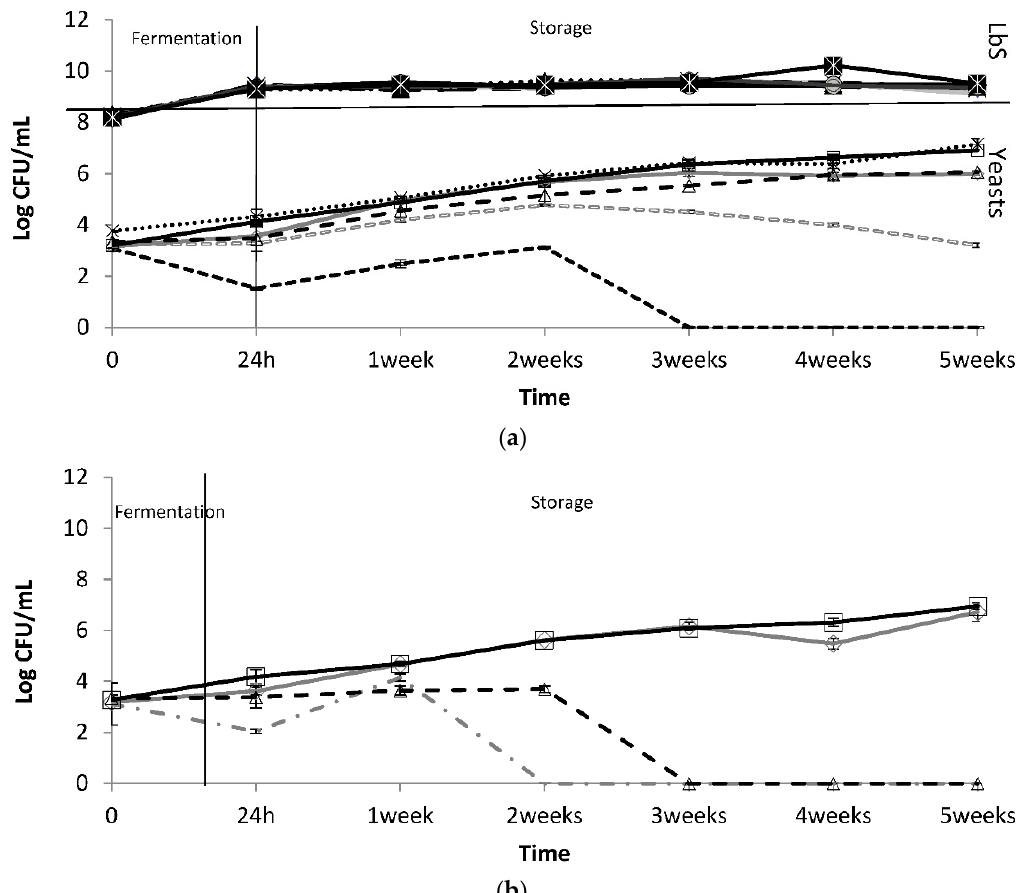
( b ) Figure 1. Growth kinetics of LbS and yeasts during the preliminary cow kefir fermentation and Figure 1. Growth kinetics of LbS and yeasts during the preliminary cow kefir fermentation and Figure 1. Growth kinetics of LbS and yeasts during the preliminary cow kefir fermentation and Figure 1. Growth kinetics of LbS and yeasts during the preliminary cow kefir fermentation and Figure 1. Growth kinetics of LbS and yeasts during the preliminary cow kefir fermentation and Figure 1. Growth kinetics of LbS and yeasts during the preliminary cow kefir fermentation and Figure 1. Growth kinetics of LbS and yeasts during the preliminary cow kefir fermentation and Figure 1. Growth kinetics of LbS and yeasts during the preliminary cow kefir fermentation and storage. At the top of the graph ( a ), the trend of the only LbS in each trial, represented as Lb fol- Figure 1. Growth kinetics of LbS and yeasts during the preliminary cow kefir fermentation and storage. At the top of the graph ( a ), the trend of the only LbS in each trial, represented as Lb fol- storage. At the top of the graph ( a ), the trend of the only LbS in each trial, represented as Lb fol- storage. At the top of the graph ( a ), the trend of the only LbS in each trial, represented as Lb fol- Figure 1. Growth kinetics of LbS and yeasts during the preliminary cow kefir fermentation and Figure 1. Growth kinetics of LbS and yeasts during the preliminary cow kefir fermentation and Figure 1. Growth kinetics of LbS and yeasts during the preliminary cow kefir fermentation and Figure 1. Growth kinetics of LbS and yeasts during the preliminary cow kefir fermentation and Figure 1. Growth kinetics of LbS and yeasts during the preliminary cow kefir fermentation and storage. At the top of the graph ( a ), the trend of the only LbS in each trial, represented as Lb fol- storage. At the top of the graph ( a ), the trend of the only LbS in each trial, represented as Lb fol- Figure 1. Growth kinetics of LbS and yeasts during the preliminary cow kefir fermentation and Figure 1. Growth kinetics of LbS and yeasts during the preliminary cow kefir fermentation and Figure 1. Growth kinetics of LbS and yeasts during the preliminary cow kefir fermentation and Figure 1. Growth kinetics of LbS and yeasts during the preliminary cow kefir fermentation and Figure 1. Growth kinetics of LbS and yeasts during the preliminary cow kefir fermentation and storage. At the top of the graph ( a ), the trend of the only LbS in each trial, represented as Lb fol- storage. At the top of the graph ( a ), the trend of the only LbS in each trial, represented as Lb fol- storage. At the top of the graph ( a ), the trend of the only LbS in each trial, represented as Lb followed lowed by the name of the associated yeast: LbS control trial ( ), LbS with D. hansenii 36 ( storage. At the top of the graph ( a ), the trend of the only LbS in each trial, represented as Lb fol- storage. At the top of the graph ( a ), the trend of the only LbS in each trial, represented as Lb fol- storage. At the top of the graph ( a ), the trend of the only LbS in each trial, represented as Lb fol- storage. At the top of the graph ( a ), the trend of the only LbS in each trial, represented as Lb fol- storage. At the top of the graph ( a ), the trend of the only LbS in each trial, represented as Lb fol- lowed by the name of the associated yeast: LbS control trial ( ), LbS with D. hansenii 36 ( lowed by the name of the associated yeast: LbS control trial ( ), LbS with D. hansenii 36 ( storage. At the top of the graph ( a ), the trend of the only LbS in each trial, represented as Lb fol- lowed by the name of the associated yeast: LbS control trial ( ), LbS with D. hansenii 36 ( storage. At the top of the graph ( a ), the trend of the only LbS in each trial, represented as Lb fol- storage. At the top of the graph ( a ), the trend of the only LbS in each trial, represented as Lb fol- storage. At the top of the graph ( a ), the trend of the only LbS in each trial, represented as Lb fol- lowed by the name of the associated yeast: LbS control trial ( ), LbS with D. hansenii 36 ( lowed by the name of the associated yeast: LbS control trial ( ), LbS with D. hansenii 36 ( storage. At the top of the graph ( a ), the trend of the only LbS in each trial, represented as Lb fol- lowed by the name of the associated yeast: LbS control trial ( ), LbS with D. hansenii 36 ( ), LbS with D. hansenii 36 ), LbS with D. hansenii 78 ( ), LbS with C. zeylanoides 13 ( ), LbS with K. Lactis by the name of the associated yeast: LbS control trial ( ), LbS with D. hansenii 36 ( ), LbS with D. hansenii 78 ( ), LbS with C. zeylanoides 13 ( ), LbS with K. Lactis lowed by the name of the associated yeast: LbS control trial ( ), LbS with D. hansenii 36 ( ), LbS with D. hansenii 78 ( ), LbS with C. zeylanoides 13 ( ), LbS with K. Lactis ), LbS with D. hansenii 78 ( ), LbS with C. zeylanoides 13 ( ), LbS with K. Lactis lowed by the name of the associated yeast: LbS control trial ( ), LbS with D. hansenii 36 ( lowed by the name of the associated yeast: LbS control trial ( ), LbS with D. hansenii 36 ( lowed by the name of the associated yeast: LbS control trial ( ), LbS with D. hansenii 36 ( lowed by the name of the associated yeast: LbS control trial ( ), LbS with D. hansenii 36 ( lowed by the name of the associated yeast: LbS control trial ( ), LbS with D. hansenii 36 ( lowed by the name of the associated yeast: LbS control trial ( ), LbS with D. hansenii 36 ( ), LbS with D. hansenii 78 ( ), LbS with C. zeylanoides 13 ( ), LbS with K. Lactis lowed by the name of the associated yeast: LbS control trial ( ), LbS with D. hansenii 36 ( ), LbS with D. hansenii 78 ( ), LbS with C. zeylanoides 13 ( ), LbS with K. Lactis lowed by the name of the associated yeast: LbS control trial ( ), LbS with D. hansenii 36 ( lowed by the name of the associated yeast: LbS control trial ( ), LbS with D. hansenii 36 ( ), LbS with D. hansenii 78 ( ), LbS with C. zeylanoides 13 ( ), LbS with K. Lactis 80 ( ), LbS with Y. lipolytica 92 ( ), and LbS with yeast consortium ( ). At the ), LbS with C. zeylanoides 13 ( ), LbS with K. Lactis 80 ( ), LbS with D. hansenii 78 ( ), LbS with C. zeylanoides 13 ( ), LbS with K. Lactis ), LbS with D. hansenii 78 ( ), LbS with C. zeylanoides 13 ( ), LbS with K. Lactis ), LbS with D. hansenii 78 ( ), LbS with C. zeylanoides 13 ( ), LbS with K. Lactis ), LbS with D. hansenii 78 ( ), LbS with C. zeylanoides 13 ( ), LbS with K. Lactis ), LbS with K. Lactis 80 ( ), LbS with Y. lipolytica 92 ( ), and LbS with yeast consortium ( ). At the ), LbS with D. hansenii 78 ( ), LbS with C. zeylanoides 13 ( ), LbS with K. Lactis ), LbS with D. hansenii 78 ( ), LbS with C. zeylanoides 13 ( ), LbS with K. Lactis 80 ( ), LbS with Y. lipolytica 92 ( ), and LbS with yeast consortium ( ). At the 80 ( ), LbS with Y. lipolytica 92 ( ), and LbS with yeast consortium ( ). At the ), LbS with D. hansenii 78 ( ), LbS with C. zeylanoides 13 ( ), LbS with K. Lactis ), LbS with D. hansenii 78 ( ), LbS with C. zeylanoides 13 ( ), LbS with K. Lactis 80 ( ), LbS with Y. lipolytica 92 ( ), and LbS with yeast consortium ( ). At the ), LbS with D. hansenii 78 ( ), LbS with C. zeylanoides 13 ( ), LbS with K. Lactis 80 ( ), LbS with Y. lipolytica 92 ( ), and LbS with yeast consortium ( ). At the 80 ( ), LbS with Y. lipolytica 92 ( ), and LbS with yeast consortium ( ). At the bottom of the graph ( a ), the trend of each yeast was represented: C. zeylanoides 13 ( ), D. ), and LbS with yeast consortium ( ). At the bottom of the graph ( a ), 80 ( ), LbS with Y. lipolytica 92 ( ), and LbS with yeast consortium ( ). At the ), LbS with Y. lipolytica 92 ( ), and LbS with yeast consortium ( ). At the bottom of the graph ( a ), the trend of each yeast was represented: C. zeylanoides 13 ( ), D. 80 ( ), LbS with Y. lipolytica 92 ( ), and LbS with yeast consortium ( ). At the 80 ( ), LbS with Y. lipolytica 92 ( ), and LbS with yeast consortium ( ). At the ), LbS with Y. lipolytica 92 ( ), and LbS with yeast consortium ( ). At the bottom of the graph ( a ), the trend of each yeast was represented: C. zeylanoides 13 ( ), D. bottom of the graph ( a ), the trend of each yeast was represented: C. zeylanoides 13 ( ), D. ), LbS with Y. lipolytica 92 ( ), and LbS with yeast consortium ( ). At the ), LbS with Y. lipolytica 92 ( ), and LbS with yeast consortium ( ). At the 80 ( ), LbS with Y. lipolytica 92 ( ), and LbS with yeast consortium ( ). At the 80 ( ), LbS with Y. lipolytica 92 ( ), and LbS with yeast consortium ( ). At the bottom of the graph ( a ), the trend of each yeast was represented: C. zeylanoides 13 ( ), D. bottom of the graph ( a ), the trend of each yeast was represented: C. zeylanoides 13 ( ), D. ), LbS with Y. lipolytica 92 ( ), and LbS with yeast consortium ( ). At the bottom of the graph ( a ), the trend of each yeast was represented: C. zeylanoides 13 ( ), D. hansenii 36 ( ), D. hansenii 78 ( ), K. Lactis 80 ( ), Y. lipolytica 92 ( ), and the trend of each yeast was represented: C. zeylanoides 13 ( bottom of the graph ( a ), the trend of each yeast was represented: C. zeylanoides 13 ( ), D. bottom of the graph ( a ), the trend of each yeast was represented: C. zeylanoides 13 ( ), D. hansenii 36 ( ), D. hansenii 78 ( ), K. Lactis 80 ( ), Y. lipolytica 92 ( ), and bottom of the graph ( a ), the trend of each yeast was represented: C. zeylanoides 13 ( ), D. bottom of the graph ( a ), the trend of each yeast was represented: C. zeylanoides 13 ( ), D. bottom of the graph ( a ), the trend of each yeast was represented: C. zeylanoides 13 ( ), D. hansenii 36 ( ), D. hansenii 78 ( ), K. Lactis 80 ( ), Y. lipolytica 92 ( ), and hansenii 36 ( ), D. hansenii 78 ( ), K. Lactis 80 ( ), Y. lipolytica 92 ( ), and bottom of the graph ( a ), the trend of each yeast was represented: C. zeylanoides 13 ( ), D. bottom of the graph ( a ), the trend of each yeast was represented: C. zeylanoides 13 ( ), D. bottom of the graph ( a ), the trend of each yeast was represented: C. zeylanoides 13 ( ), D. bottom of the graph ( a ), the trend of each yeast was represented: C. zeylanoides 13 ( ), D. hansenii 36 ( ), D. hansenii 78 ( ), K. Lactis 80 ( ), Y. lipolytica 92 ( ), and hansenii 36 ( ), D. hansenii 78 ( ), K. Lactis 80 ( ), Y. lipolytica 92 ( ), and bottom of the graph ( a ), the trend of each yeast was represented: C. zeylanoides 13 ( ), D. hansenii 36 ( ), D. hansenii 78 ( ), K. Lactis 80 ( ), Y. lipolytica 92 ( ), and ), and the yeast consortium ( ), without hansenii 36 ( ), D. hansenii 78 ( ), K. Lactis 80 ( ), Y. lipolytica 92 ( ), and the yeast consortium ( ), without distinction among the species. Graph ( b ) represents the hansenii 36 ( ), D. hansenii 78 ( ), K. Lactis 80 ( ), Y. lipolytica 92 ( ), and hansenii 36 ( ), D. hansenii 78 ( ), K. Lactis 80 ( ), Y. lipolytica 92 ( ), and hansenii 36 ( ), D. hansenii 78 ( ), K. Lactis 80 ( ), Y. lipolytica 92 ( ), and ), K. Lactis 80 ( the yeast consortium ( ), without distinction among the species. Graph ( b ) represents the ), K. Lactis 80 ( hansenii 36 ( ), D. hansenii 78 ( ), K. Lactis 80 ( ), Y. lipolytica 92 ( ), and the yeast consortium ( ), without distinction among the species. Graph ( b ) represents the the yeast consortium ( ), without distinction among the species. Graph ( b ) represents the hansenii 36 ( ), D. hansenii 78 ( ), K. Lactis 80 ( ), Y. lipolytica 92 ( ), and hansenii 36 ( ), D. hansenii 78 ( ), K. Lactis 80 ( ), Y. lipolytica 92 ( ), and ), K. Lactis 80 ( ), Y. lipolytica 92 ( ), and the yeast consortium ( ), without distinction among the species. Graph ( b ) represents the the yeast consortium ( ), without distinction among the species. Graph ( b ) represents the the yeast consortium ( ), without distinction among the species. Graph ( b ) represents the distinction among the species. Graph ( b ) represents the growth kinetics of the single species forming the yeast consortium ( ), without distinction among the species. Graph ( b ) represents the growth kinetics of the single species forming the yeast consortium: D. hansenii 38 + 78 ( ), C. the yeast consortium ( ), without distinction among the species. Graph ( b ) represents the the yeast consortium ( ), without distinction among the species. Graph ( b ) represents the the yeast consortium ( ), without distinction among the species. Graph ( b ) represents the growth kinetics of the single species forming the yeast consortium: D. hansenii 38 + 78 ( ), C. ), without distinction among the species. Graph ( b ) represents the the yeast consortium ( ), without distinction among the species. Graph ( b ) represents the growth kinetics of the single species forming the yeast consortium: D. hansenii 38 + 78 ( ), C. the yeast consortium ( ), without distinction among the species. Graph ( b ) represents the growth kinetics of the single species forming the yeast consortium: D. hansenii 38 + 78 ( ), C. the yeast consortium ( ), without distinction among the species. Graph ( b ) represents the ), without distinction among the species. Graph ( b ) represents the growth kinetics of the single species forming the yeast consortium: D. hansenii 38 + 78 ( ), C. growth kinetics of the single species forming the yeast consortium: D. hansenii 38 + 78 ( ), C. growth kinetics of the single species forming the yeast consortium: D. hansenii 38 + 78 ( ), C. the yeast consortium: D. hansenii 38 + 78 ( zeylanoides 13 ( ), K. lactis 80 ( ), and Y. lipolytica 92 ( ). Data means ± standard growth kinetics of the single species forming the yeast consortium: D. hansenii 38 + 78 ( ), C. zeylanoides 13 ( ), K. lactis 80 ( ), and Y. lipolytica 92 ( ). Data means ± standard growth kinetics of the single species forming the yeast consortium: D. hansenii 38 + 78 ( ), C. growth kinetics of the single species forming the yeast consortium: D. hansenii 38 + 78 ( ), C. zeylanoides 13 ( ), K. lactis 80 ( ), and Y. lipolytica 92 ( ). Data means ± standard zeylanoides 13 ( ), K. lactis 80 ( ), and Y. lipolytica 92 ( ). Data means ± standard growth kinetics of the single species forming the yeast consortium: D. hansenii 38 + 78 ( growth kinetics of the single species forming the yeast consortium: D. hansenii 38 + 78 ( ), C. growth kinetics of the single species forming the yeast consortium: D. hansenii 38 + 78 ( ), C. growth kinetics of the single species forming the yeast consortium: D. hansenii 38 + 78 ( ), C. zeylanoides 13 ( ), K. lactis 80 ( ), and Y. lipolytica 92 ( ). Data means ± standard zeylanoides 13 ( ), K. lactis 80 ( ), and Y. lipolytica 92 ( ). Data means ± standard growth kinetics of the single species forming the yeast consortium: D. hansenii 38 + 78 ( ), C. zeylanoides 13 ( ), K. lactis 80 ( ), and Y. lipolytica 92 ( ). Data means ± standard deviations are represented as error bars. deviations are represented as error bars. deviations are represented as error bars. deviations are represented as error bars. zeylanoides 13 ( ), K. lactis 80 ( ), and Y. lipolytica 92 ( ). Data means ± standard zeylanoides 13 ( ). Data means ± standard deviations are represented as error bars. deviations are represented as error bars. zeylanoides 13 ( ), K. lactis 80 ( ), and Y. lipolytica 92 ( ). Data means ± standard zeylanoides 13 ( ), K. lactis 80 ( ), and Y. lipolytica 92 ( ). Data means ± standard zeylanoides 13 ( ), K. lactis 80 ( ), and Y. lipolytica 92 ( ). Data means ± standard ). Data means ± standard deviations are represented as error bars. deviations are represented as error bars. deviations are represented as error bars. deviations are represented as error bars. deviations are represented as error bars. deviations are represented as error bars.